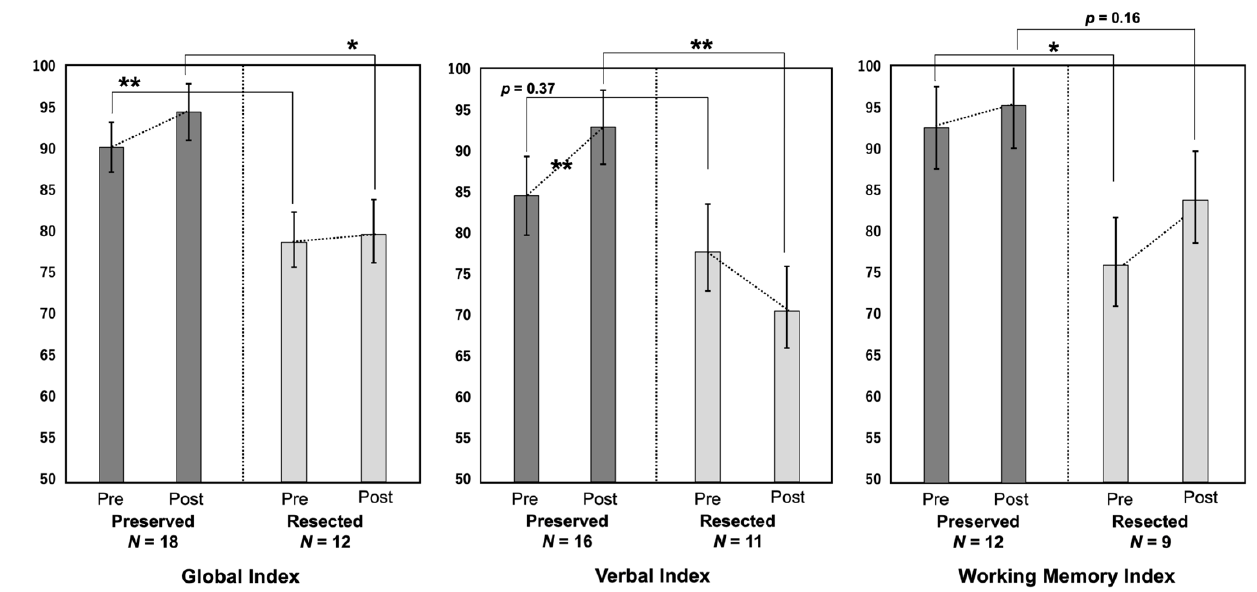
Figure 4. The pre- and postoperative scores in the three cognitive indices (global index, verbal index, and working memory index) are compared. *: p < 0.05, **: p < 0.01. Table 4. Analysis of covariance for the effect of hippocampal resection on postoperative cognitive